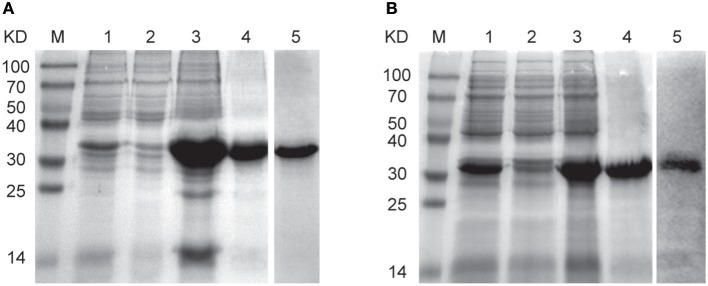
The SDS-PAGE and Western blot results for identifying the expression and purity of EVP1 (A) and CVP1 (B). (A) M: protein marker; lane 1 is the total bacterial proteins of pET22b (+)-EVP1; lane 2 is the supernatant of bacterial lysates; lane 3 is the precipitation of bacterial lysates; lane 4 is the purified EVP1 protein; lane 5 is Western blot by anti-EV71 antibodies. (B) M: protein marker; lane 1 is the total bacterial proteins of pET22b (+)-CVP1; lane 2 is the supernatant of bacterial lysates; lane 3 is the precipitation of bacterial lysates; lane 4 is the purified CVP1 protein; lane 5 is Western blot by anti-CB3 antibodies.